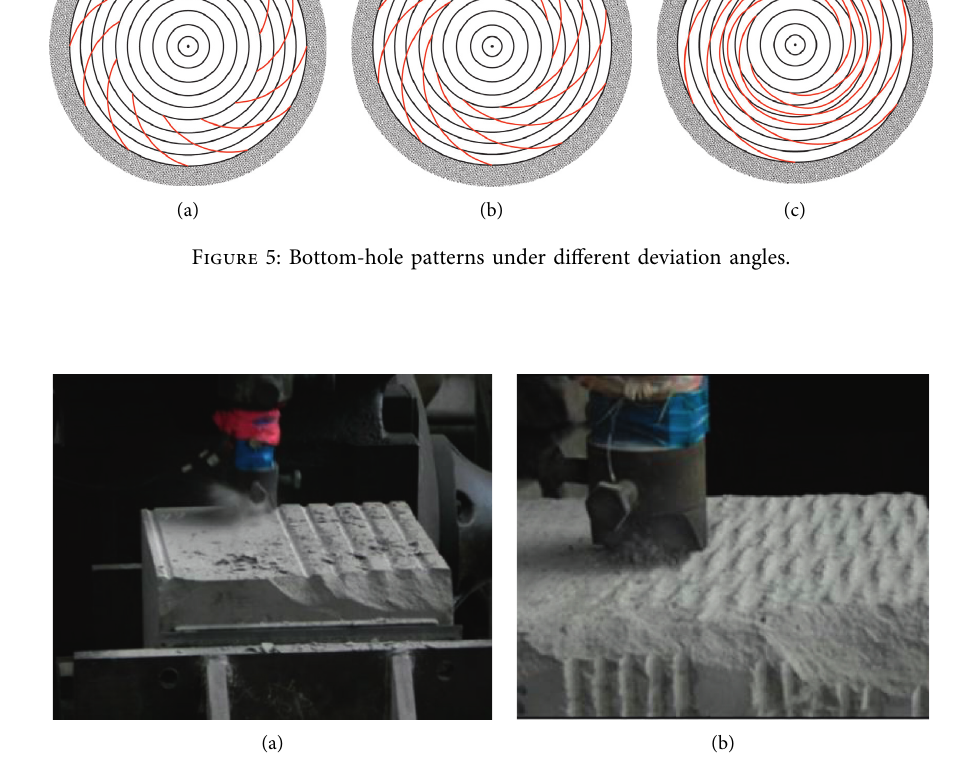
Figure 6: Cutting process under different cutting modes. (a) Unidirectional cutting, (b) Cross-cutting.